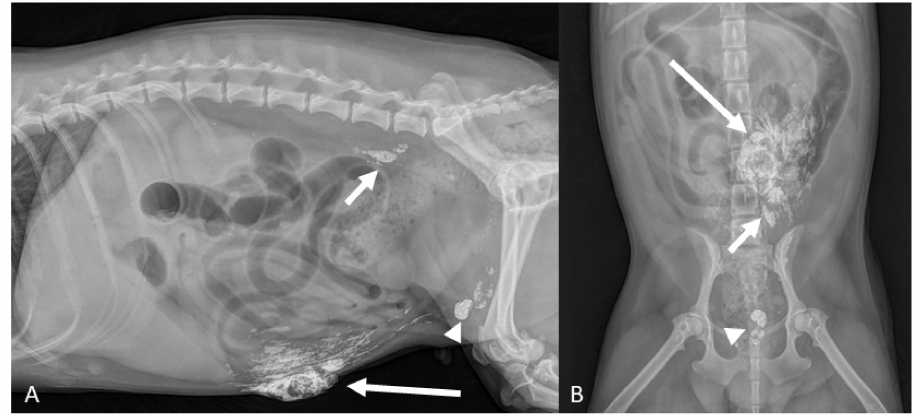
Figure 3. ( A , B ) Maltese dog, 8 yr (Case #6). Right lateral and ventro-dorsal radiographic of the ab- domen taken 24 h after lipiodol injection in the fourth neoplastic mammary gland (( A )—long arrow). Lympatics from the fourth gland that drain into the superficial inguinal lymph nodes are demon- strated (( A , B )—arrowheads). Medial iliac lymph nodes are also opacified (( A , B )—short